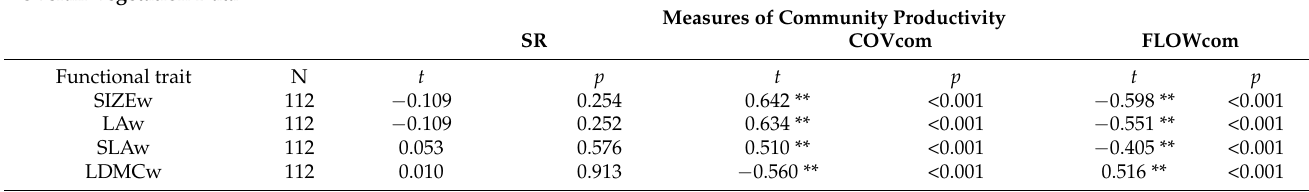
positive correlation with the vegetation cover in the xerophile dataset (Table 3).